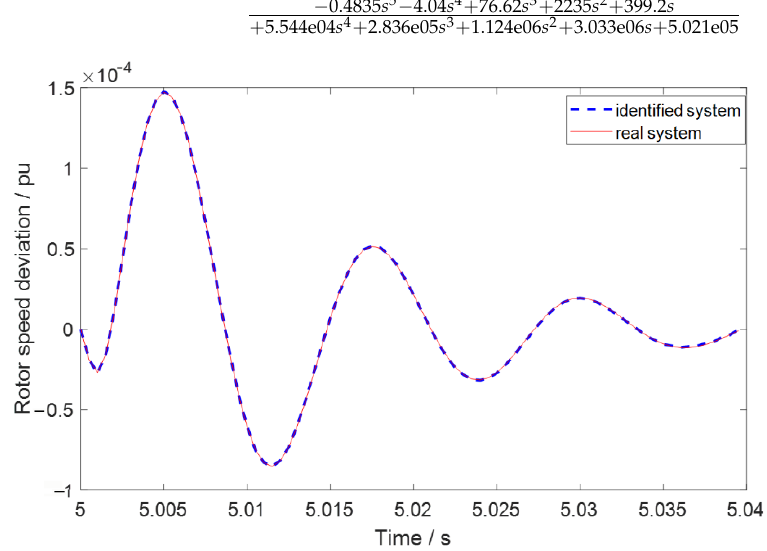
Figure 10. The comparison between the real curve and identified curve of reactive power control loop.